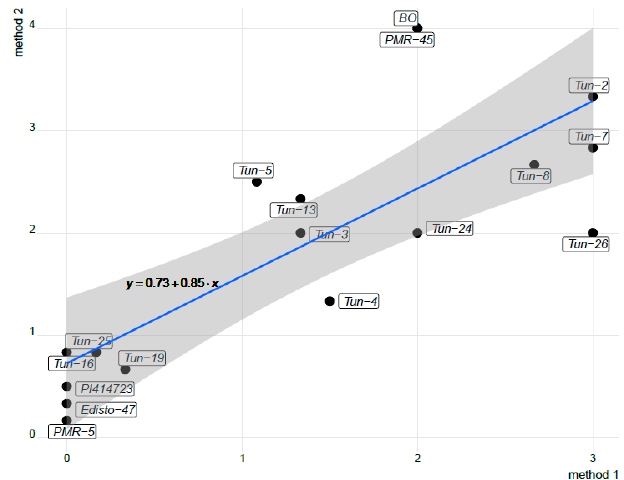
Figure 5. Display of the differences in the P. xanthii Race 2 responses between the methods of evaluation (Method 1: artificial inoculation in growth chamber; Method 2: natural conditions of infection under greenhouse). Accessions lying near the regression line show the same reaction whatever the method used. The confidence interval is marked with a grey area. All accessions outside the grey area are deviating, showing differences in their reaction among the methods. The straight regression line and the highly significant correlation (0.79***) of genetic estimations between Methods 1 and 2 generally indicate a high correspondence of landrace responses between the two methods. Tun-9 and Tun-18 were evaluated in Method 1 but not in Method 2, so they are not presented in this figure. The extent of variance components influencing the response to P. xanthii Race 2 showed that 57% of the total variance could be explained by the accession, i.e., genetic variance, with a high value of 0.86 for the estimated heritability (Figure 6). The interaction between accession and method of evaluation explained 11% of the total variance and the method used contributed only 6% to the total phenotypic variance, suggesting a minor influence. Residual variance captured a quarter of the total variance, highlighting that only a small part of the total variance could not be explained by any of the applied factors.